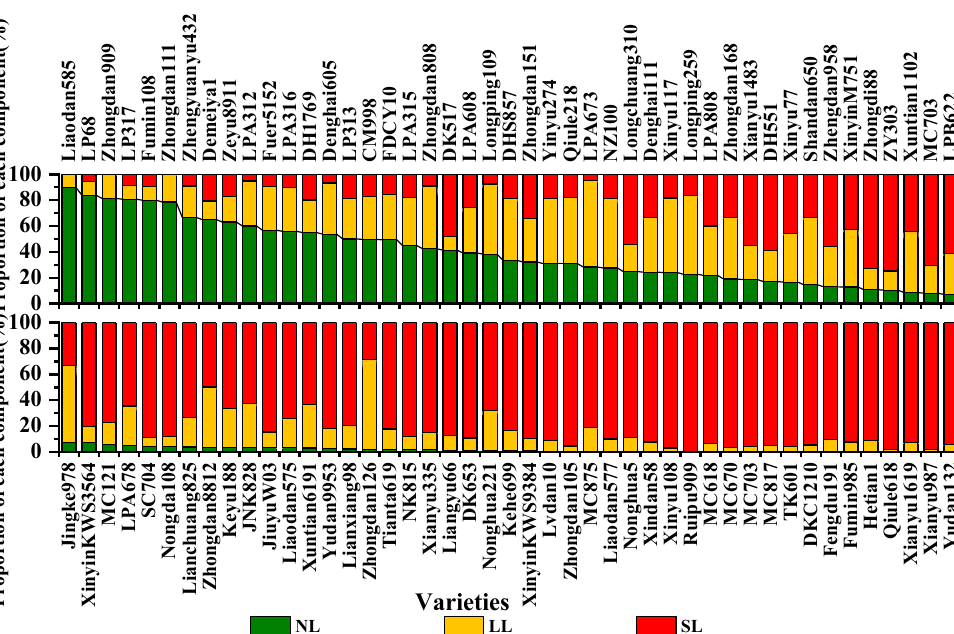
Figure 16. Statistical analysis of degree of lodging of different maize varieties. Note: The fractions of NL, LL, and SL for each maize variety are indicated by green, yellow, and red, respectively. The three varieties most resistant to lodging are Liaodan 585, LP68, and Zhongdan909, respectively.